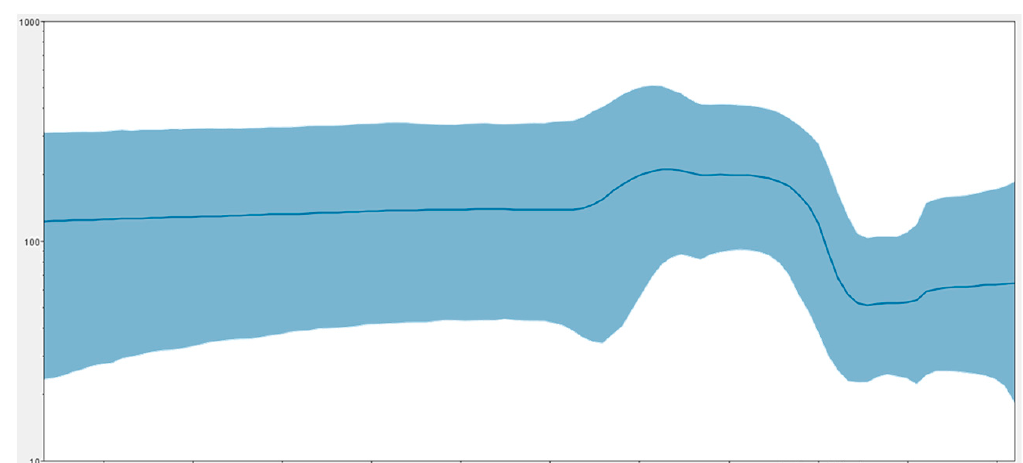
Figure 1. ( a ) NSP4 maximum likelihood phylogenetic tree showing the genotype clustering. Geno- types that clustered within a branch are shown in parentheses. The E12 genotype is colored in red. ( b ) Phylodynamic NSP4 E12 genotype. Branches are colored according to their host (equine, blue; bovine, green; guanaco, red; interspecies transmission, purple; out-group, gray). Sequences obtained in this study are shown with a circle on strain name. ( c ) Population dynamics of RVA NSP4 E12 genes. The effective numbers of infections through time (Ne τ ) obtained from the analysis of NSP4 E12 genes, under the UCLN-BSP models. The solid lines denote median values, while blue shadows denote the 95% highest posterior density (HPD) values.